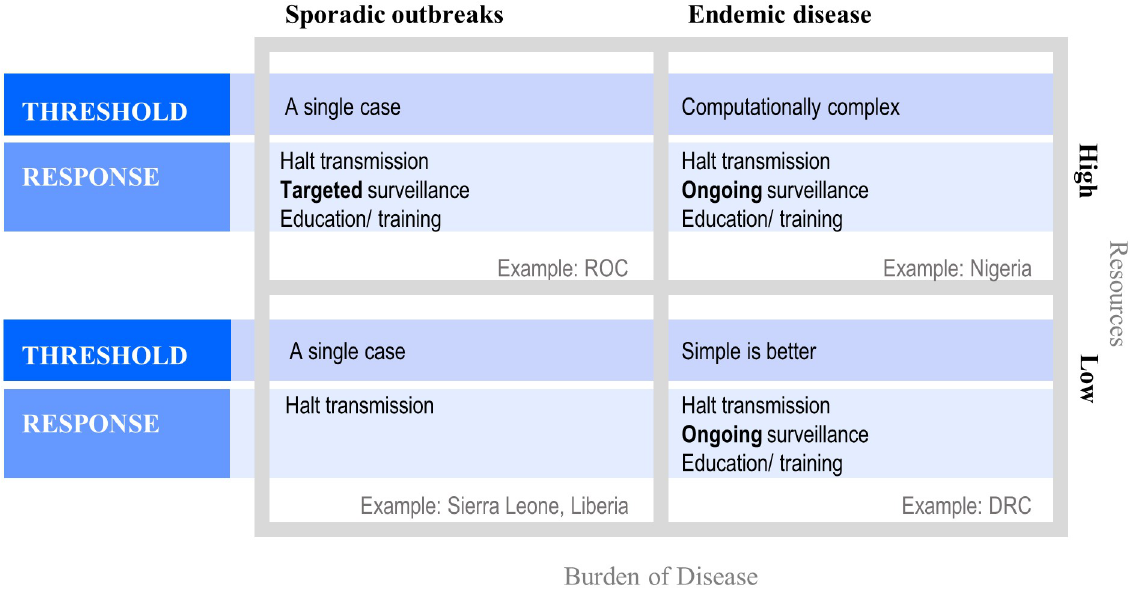
Fig 4. Considerations for thresholds and response goals across gradients of endemicity and resources available for public health. Thresholds for defining aberrant disease events are most relevant in the context of endemic disease; when disease is rare, contrastingly, a single case can serve as an alarm. Response goals should be prioritized—the minimal goal is always to halt transmission, but when resources are available and/or burden of disease is high, public health authorities should strive to improve surveillance and education. For monkeypox, high endemicity and low resources are exemplified by Tshuapa Province, DRC. Nigeria might be an example of high burden of disease and ample public health resources—recently confirmed monkeypox cases indicate frequent autochthonous transmission, but more data is required to determine the true burden of disease. Nigeria is currently in the process of laying the groundwork for long-term monkeypox surveillance programs—a major contrasting point with Tshuapa Province is better access to real-time case confirmation. Low monkeypox endemicity might be exemplified by the high-resource Republic of the Congo (ROC) and low-resource Liberia or Sierra Leone. In this framework, resources available for public health are defined as the general domestic health expenditures per capita.